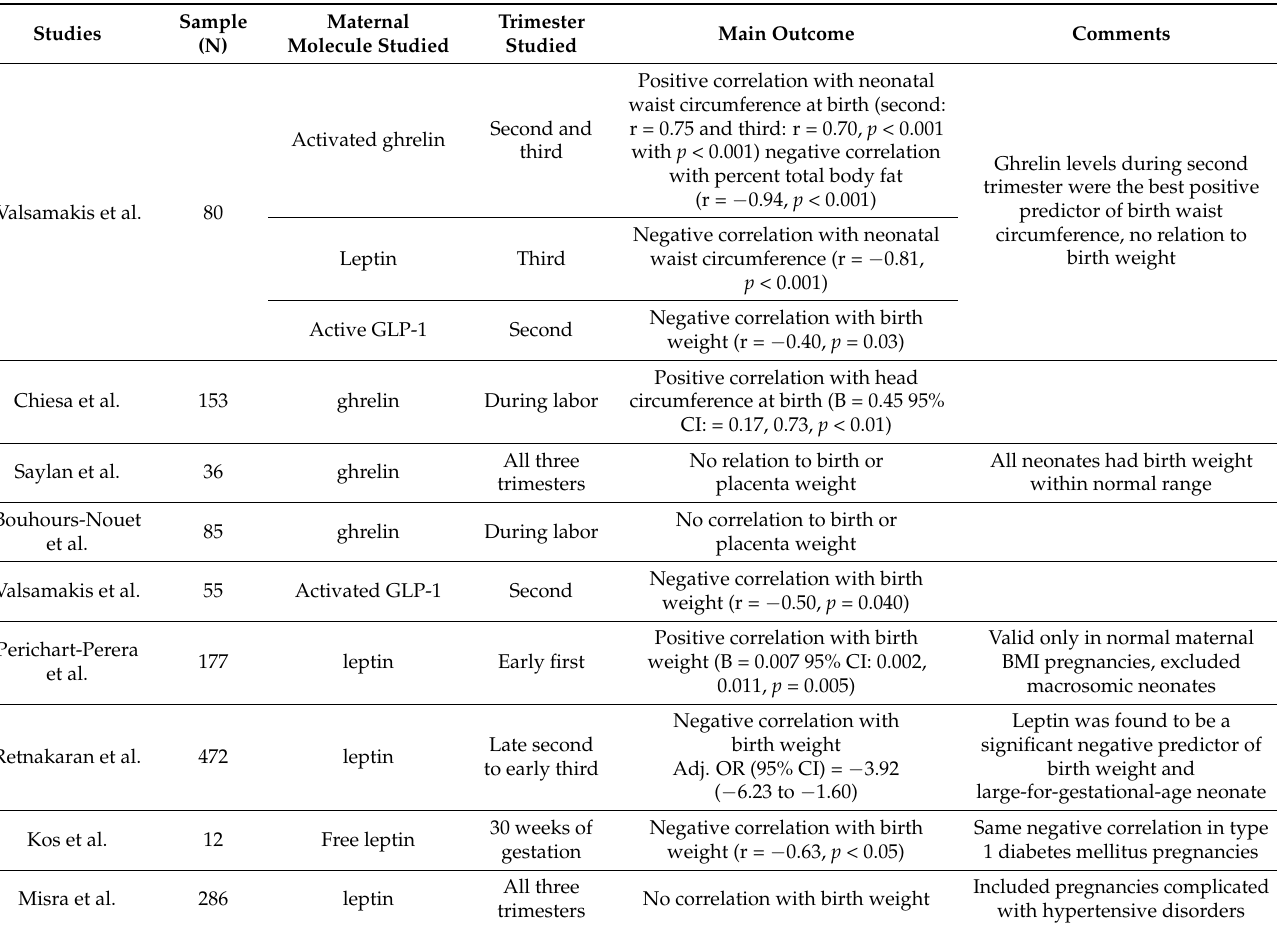
Table 2. Important study aspects of maternal molecules implicated in appetite regulation, in relation to neonatal anthropometric measurements at